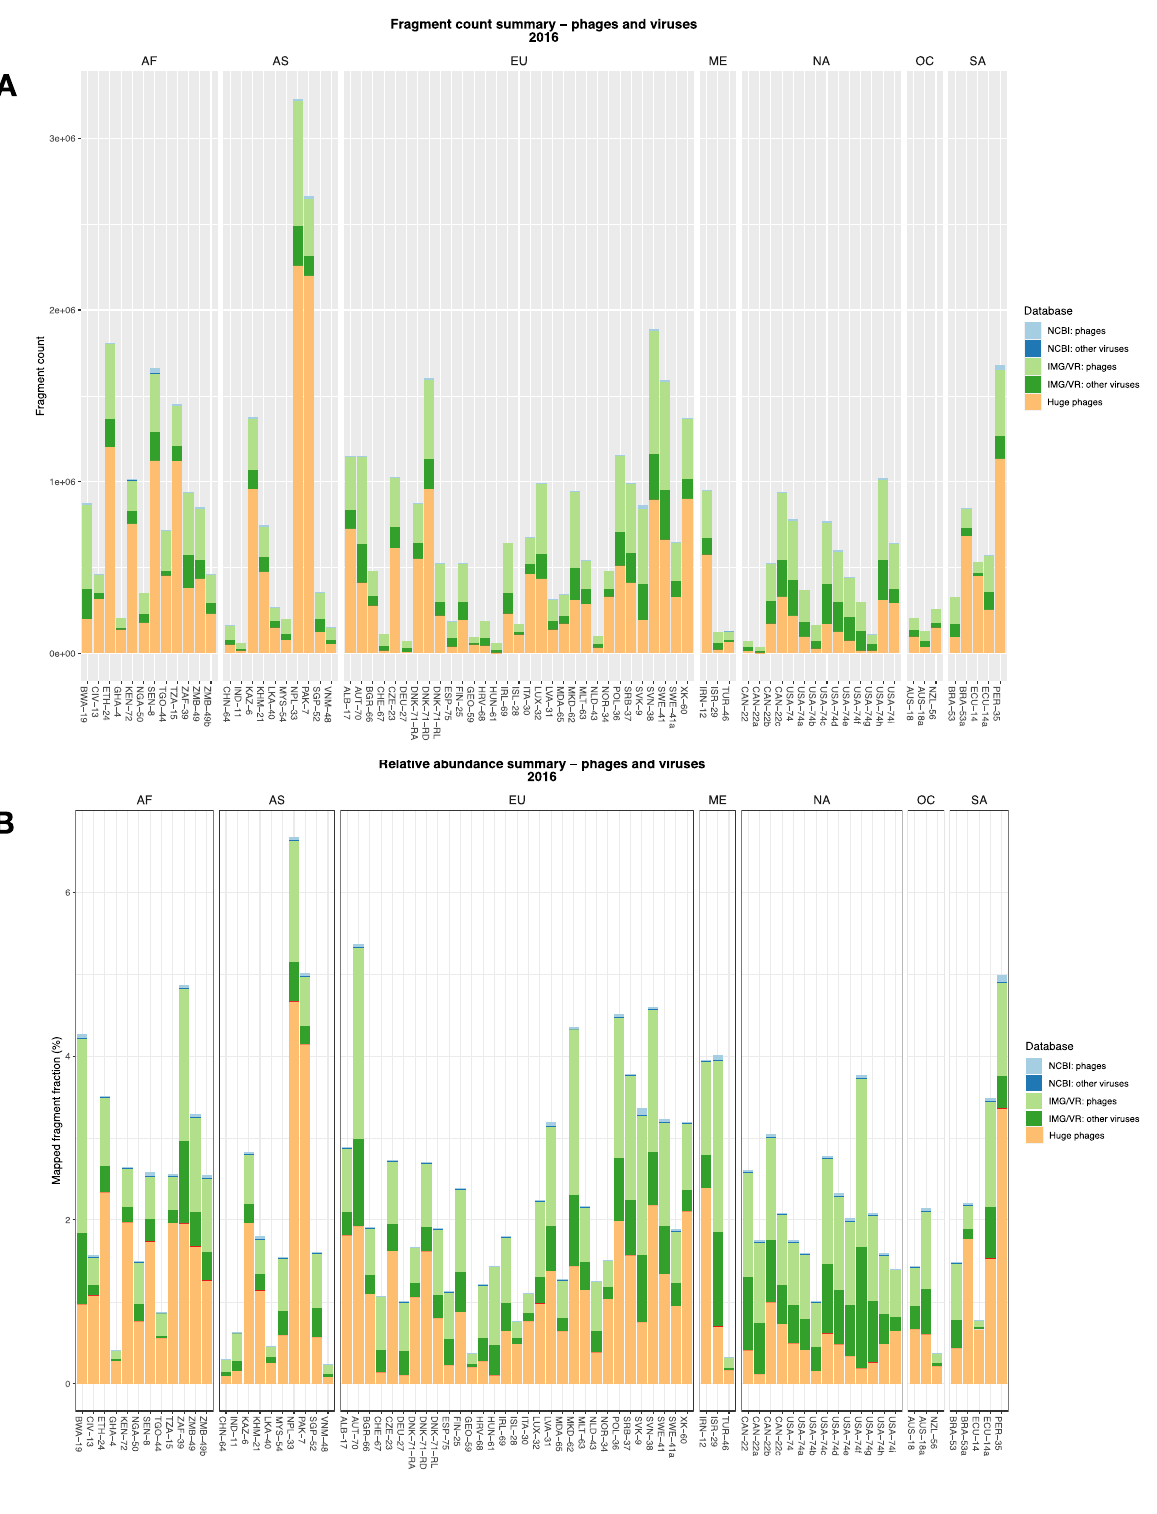
Figure 1. Fragment count ( A ) and relative abundance ( B ) summary of phages and viruses. AF Africa, AS Asia, EU Europe, NA North America, ME Middle East, OC Oceania, SA South